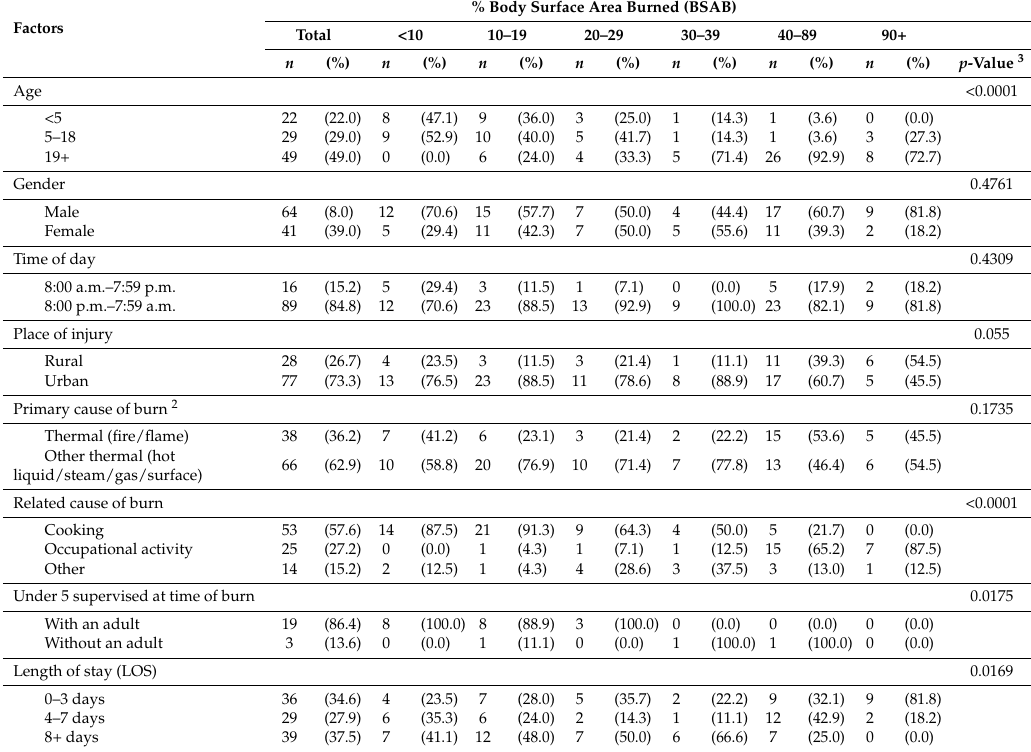
Table 2. Environmental/adult supervision, and LOS by Body Surface Area Burned 1